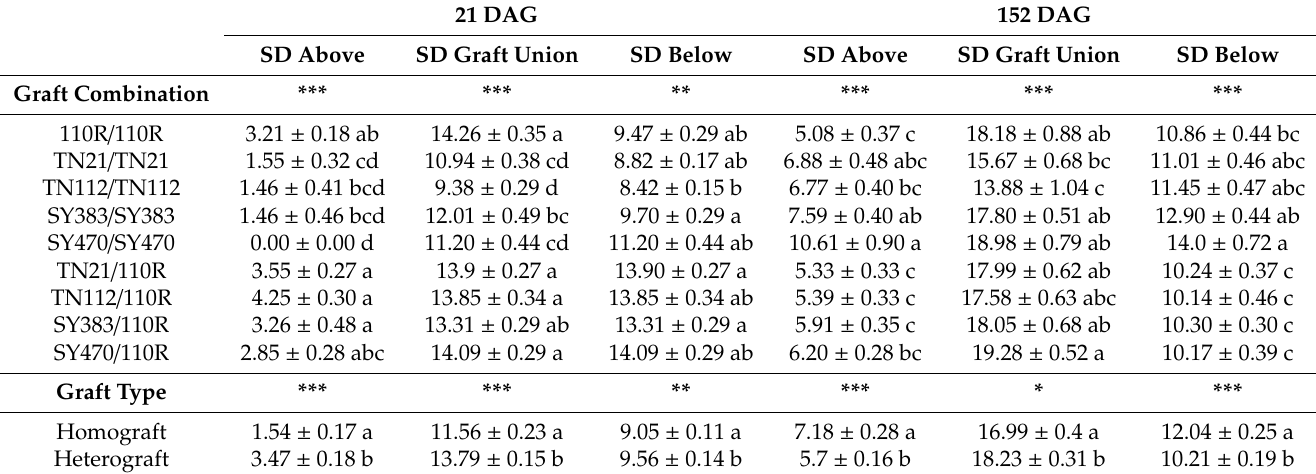
Table 2. Mean values of the Stem Diameters (SD) detected at 21 and 152